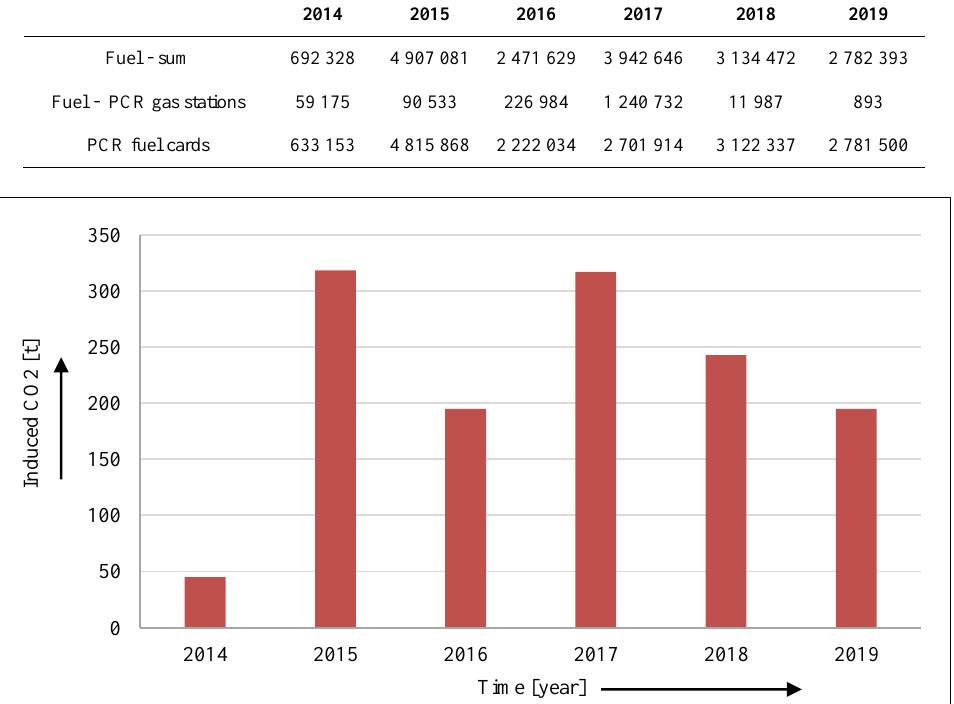
Figure 10. Induced CO 2